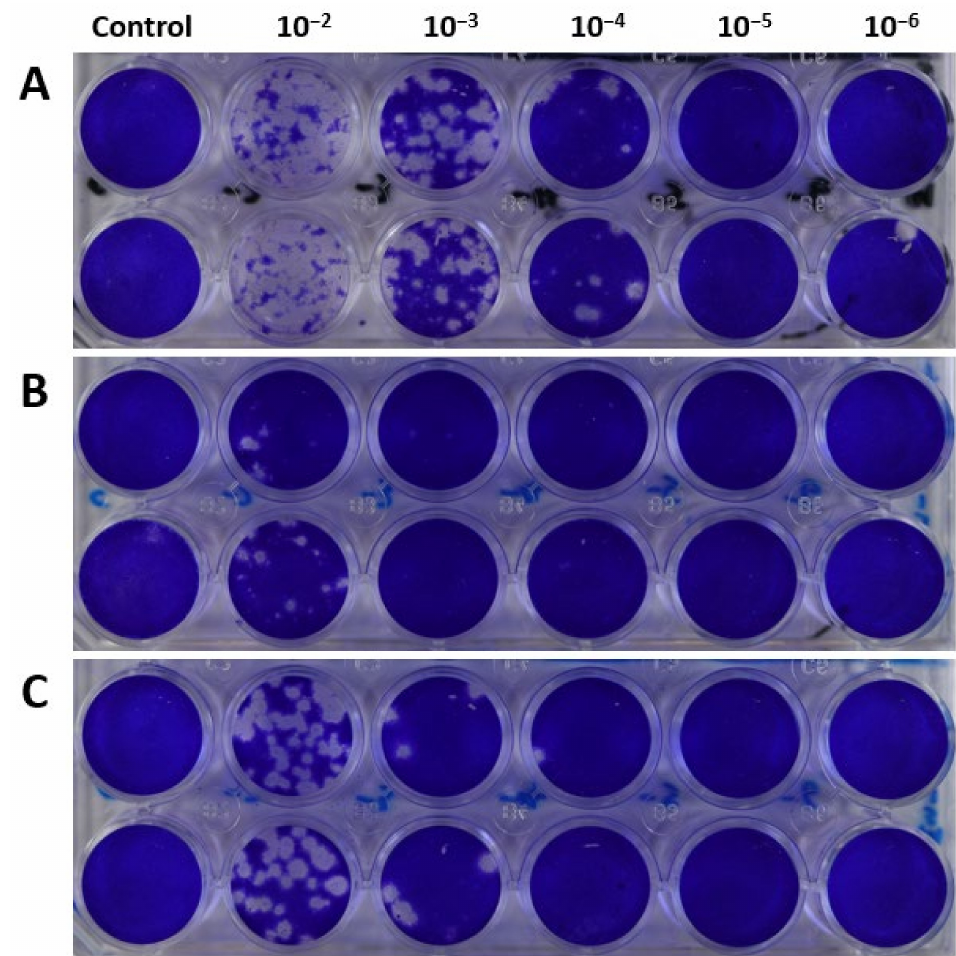
Figure 5. Representative virus plaque assay plates of the MDCK-SIAT1 passages ( A ) P3, ( B ) P4, and ( C ) P5, illustrating increases in plaque sizes from P3 to